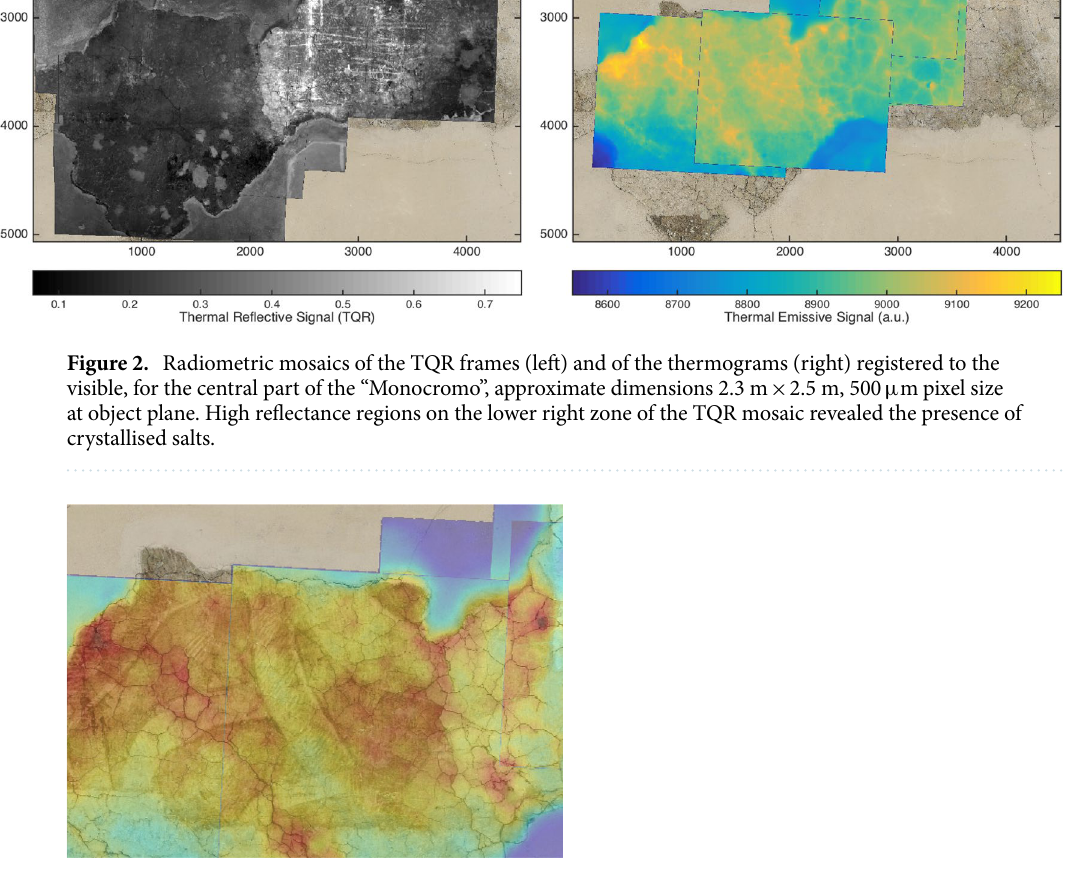
Figure 3. Alpha fusion between registered radiometric thermal image and visible